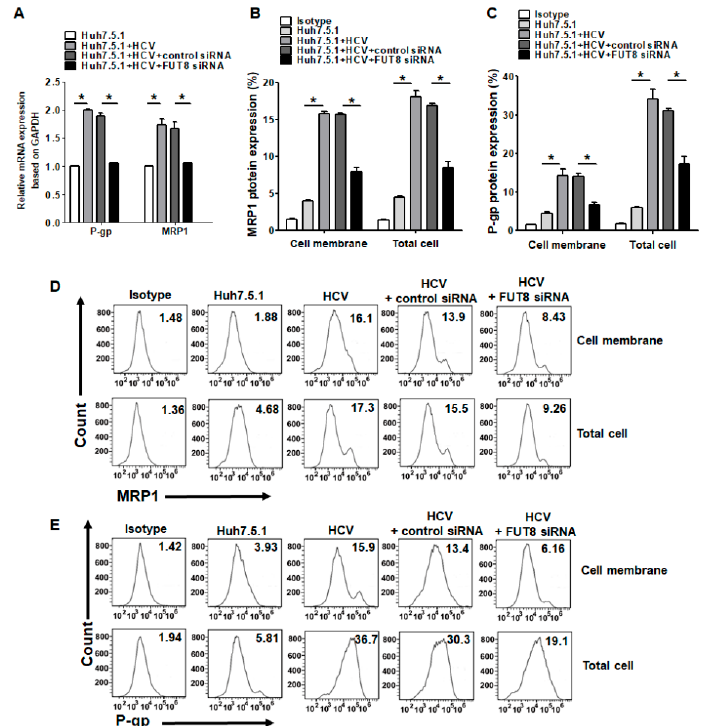
Figure 5. Effects of HCV infection on the expression of multidrug resistance-associated proteins. ( A ) Statistical analysis of qRT-PCR of the mRNA expression of MRP1 and P-gp after HCV infection in Huh7.5.1 cells with or without knockdown of FUT8. Statistical analysis of flow cytometry data for the expression of MRP1 ( B ) and P-gp ( C ) in Huh7.5.1 cells. ( D , E ) Representative data of flow cytometry analysis for the expression of MRP1 ( D ) and P-gp ( E ) in Huh7.5.1 cells after HCV infection or knockdown with FUT8. * p < 0.05.